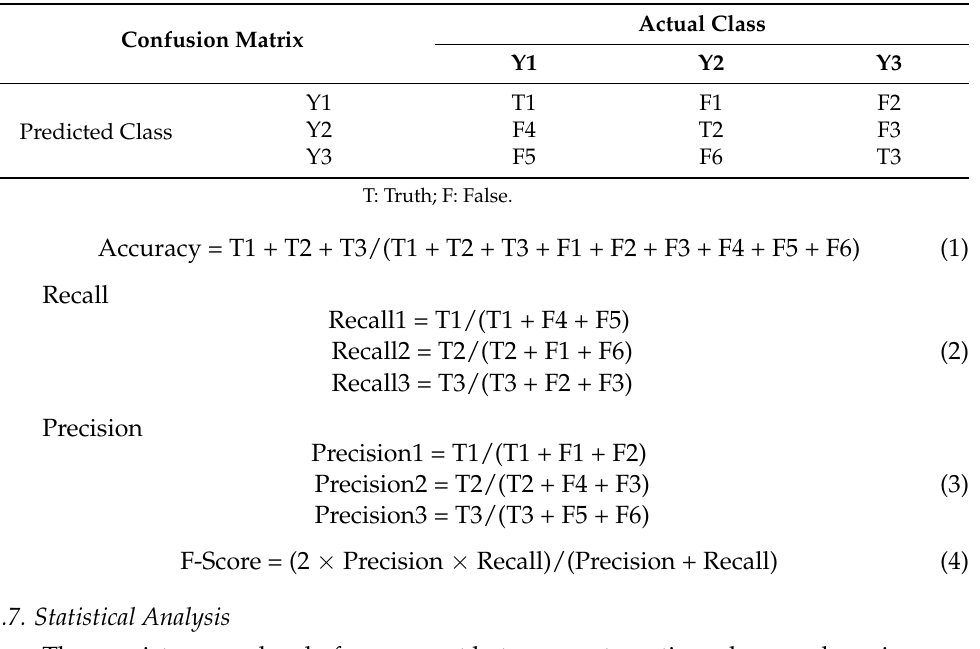
Table 2. Confusion matrix for three